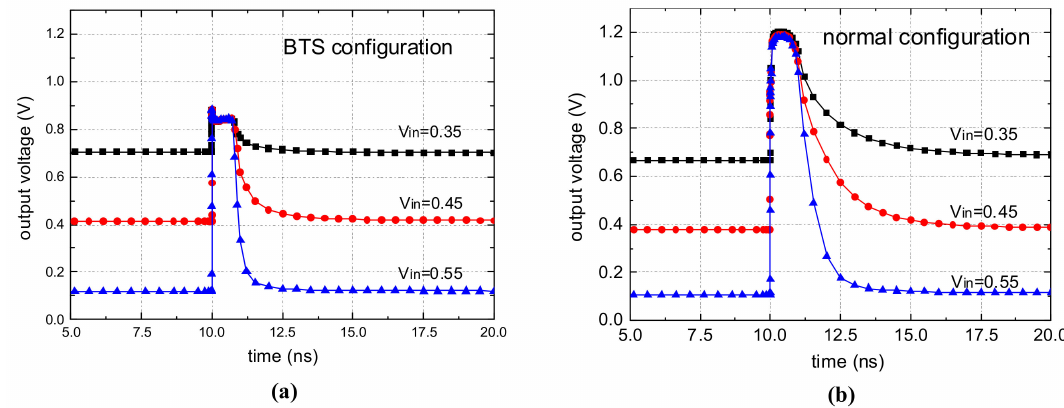
Figure 3. Simulated transient voltages in three input conditions, ( a ) struck transistor with BTS configuration; ( b ) struck transistor with normal configuration.